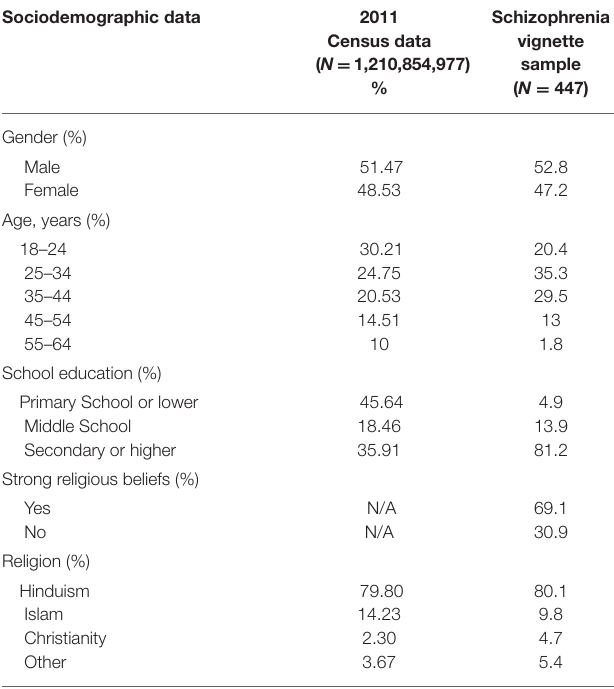
TABLE 1 | Sociodemographic characteristics of survey sample in percentage in comparison to the total population of India according to the census of 2011. Sociodemographic